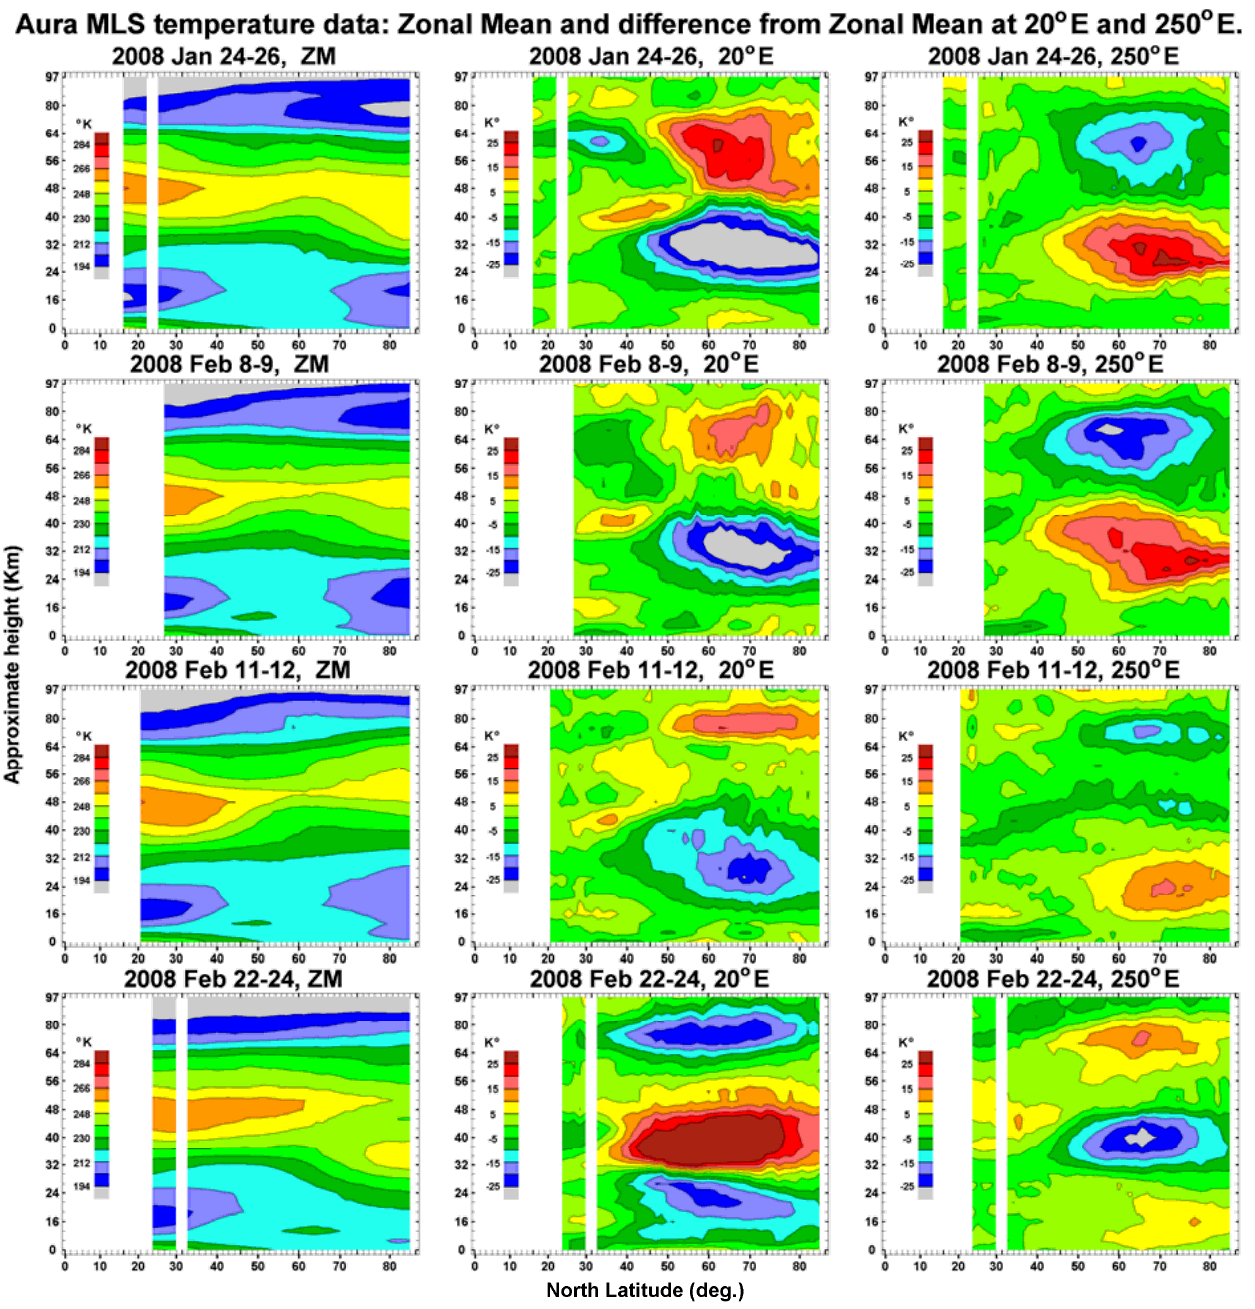
Fig. 8. Same as Fig. 5, but for four time-intervals during winter 2007/2008. See text for